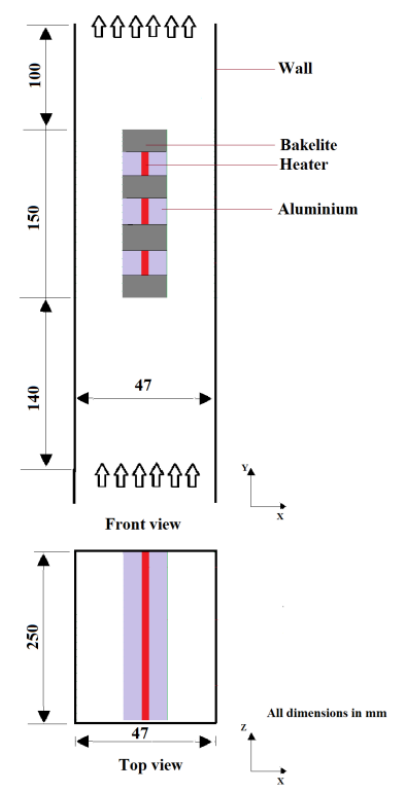
Figure 1. Physical domain of the vertical